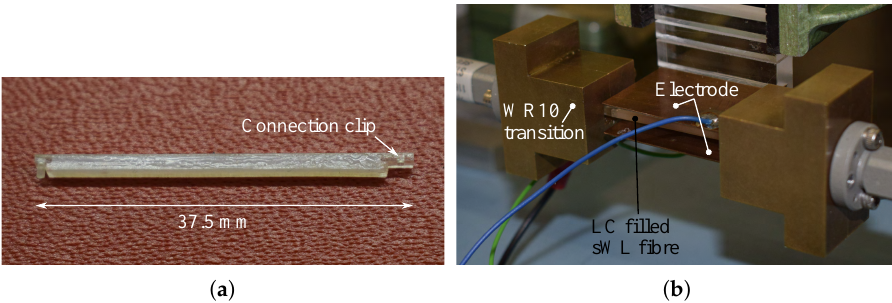
Figure 7. ( a ) Fabricated LC sWL fibre, as presented in [20]. ( b ) Connection clips are designed to hold the phase shifter in place for measurement. Two copper plates are used as electrodes for LC biasing.